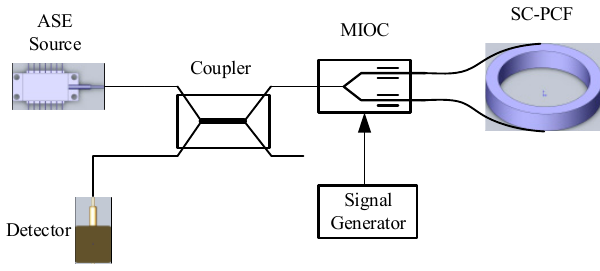
Figure 1. Schematic diagram of a solid core photonic crystal fiber-optic gyroscope.